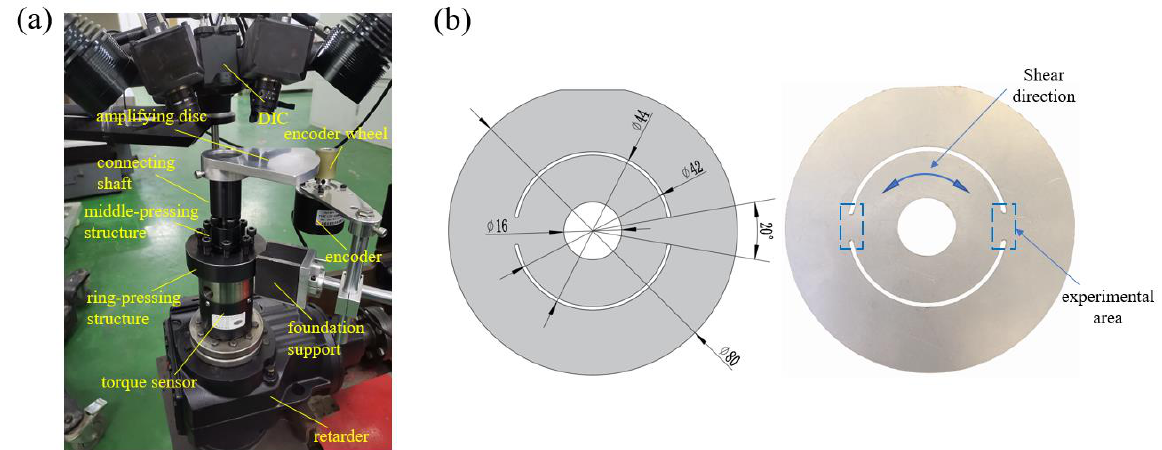
Figure 1. ( a ) Cyclic shear fatigue testing machine, ( b ) twin bridge shear specimen.